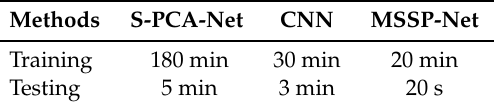
Table 4. The executing times of compared